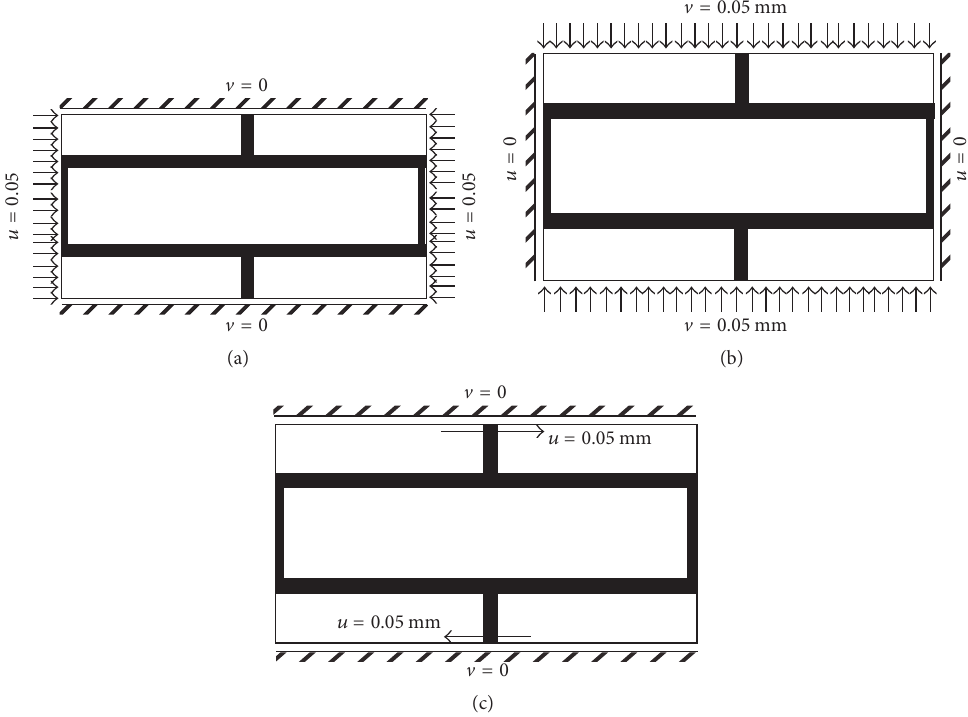
Figure 4: Load cases of imposed boundary displacement: (a) load case 1: horizontal compression; (b) load case 2: vertical compression force; (c) load case 3: horizontal shear